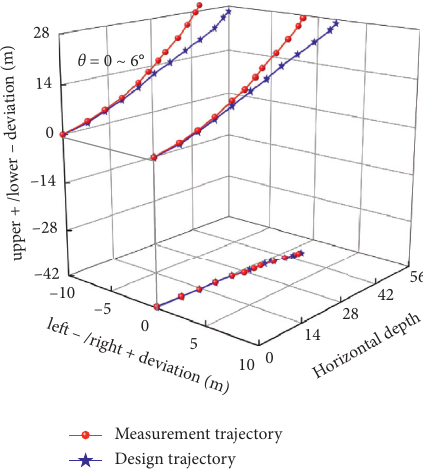
Figure 8: Borehole offset when the angle of encountered layer is greater than the critical value.